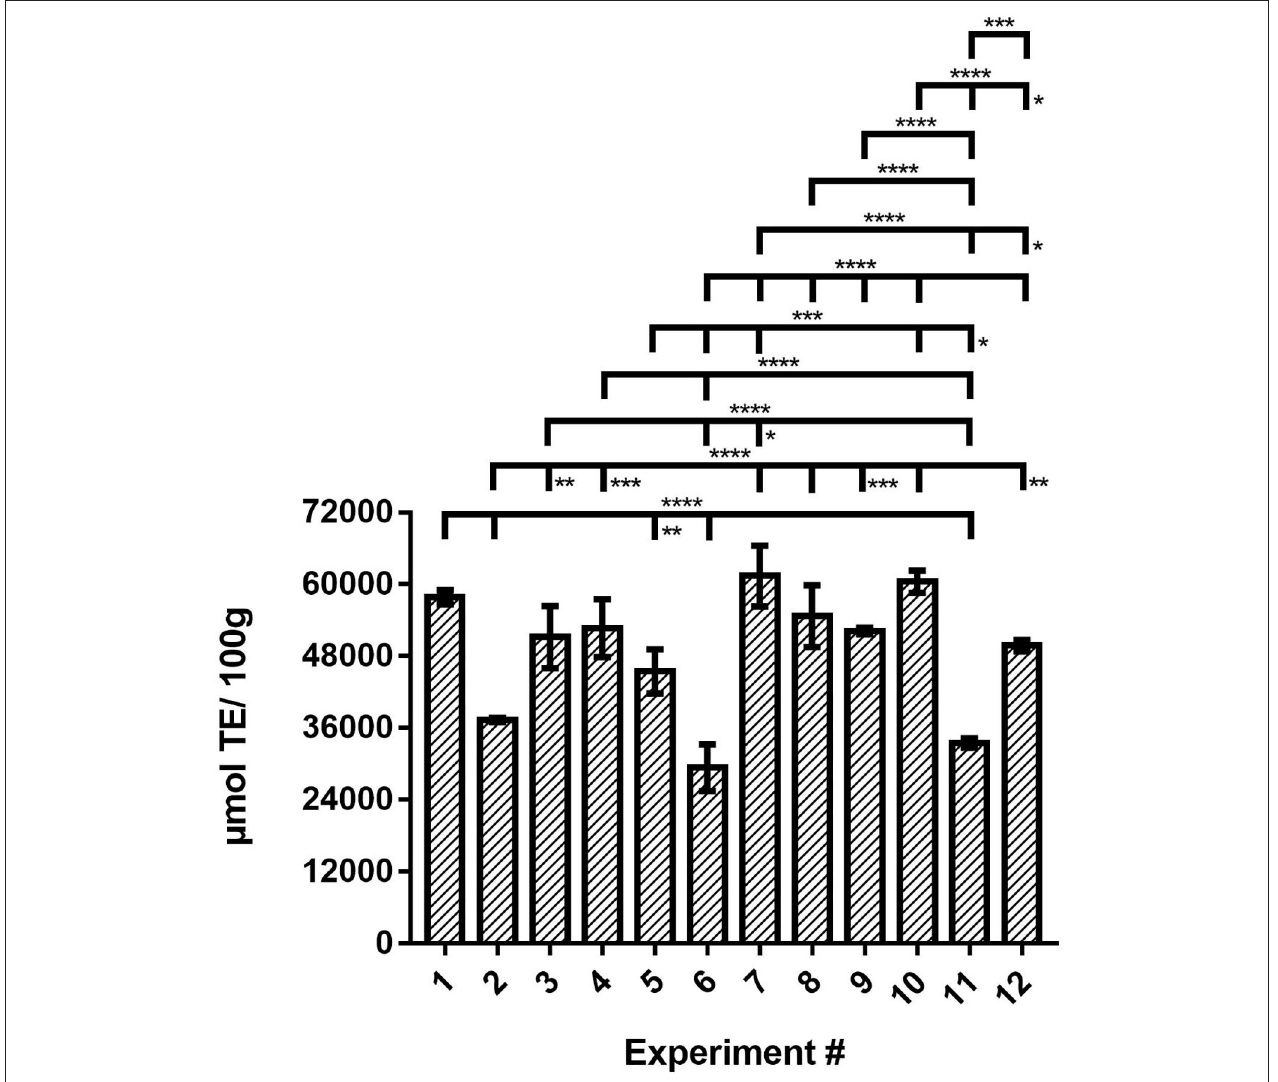
FIGURE 3 | AA of the OLEU-EE determined by DPPH radical scavenging activity assay and comparison of mean ± SD values by one-way ANOVA with Tukey’s test of the AA for the 12 experiments. With a confidence interval of 95% ( α = 0.05), significance is represented by brackets with: one asterisk (*) identify adjusted P- values between 0.01 and 0.05, two asterisks (**) identify adjusted P- values between 0.01 and 0.001, three asterisks (***) identify adjusted P- values between 0.001 and 0.0001, and four asterisks (****) identify adjusted P- values < 0.0001.